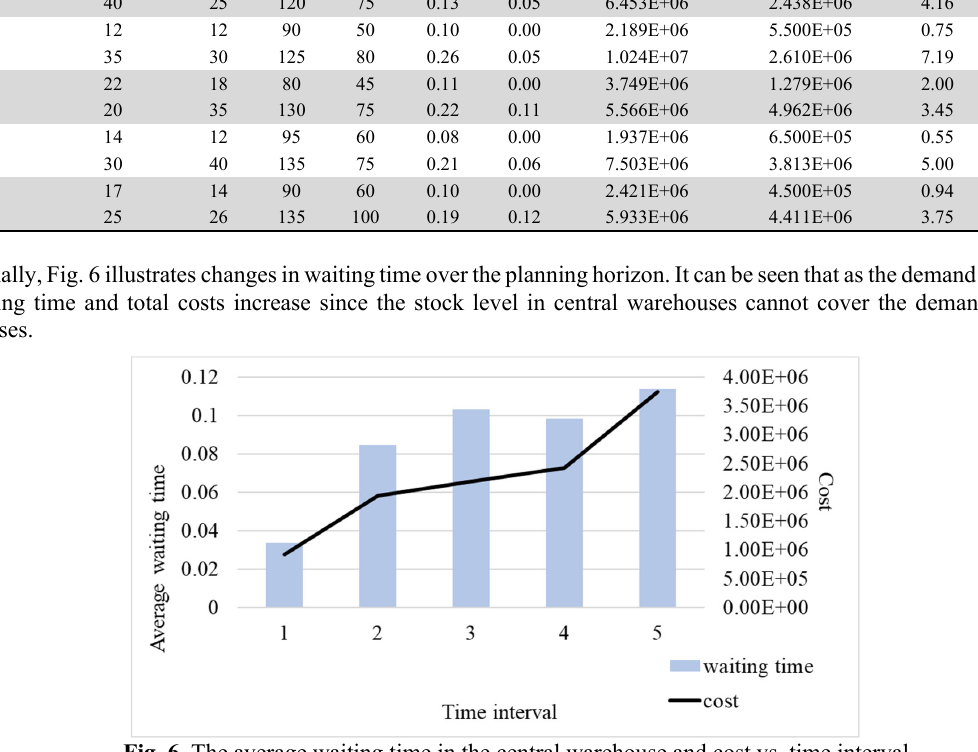
Fig. 6. The average waiting time in the central warehouse and cost vs. time